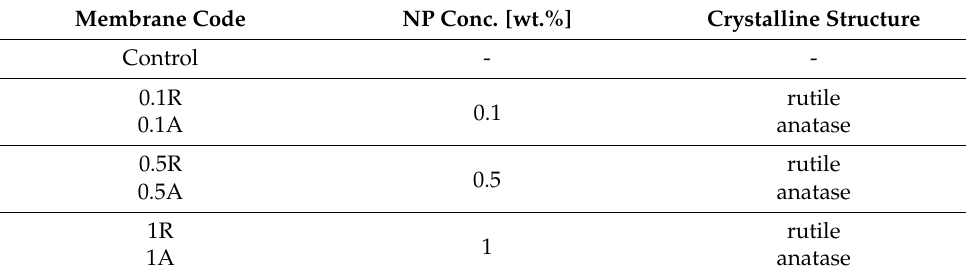
Table 1. Concentrations of added nanomaterials in the polymeric